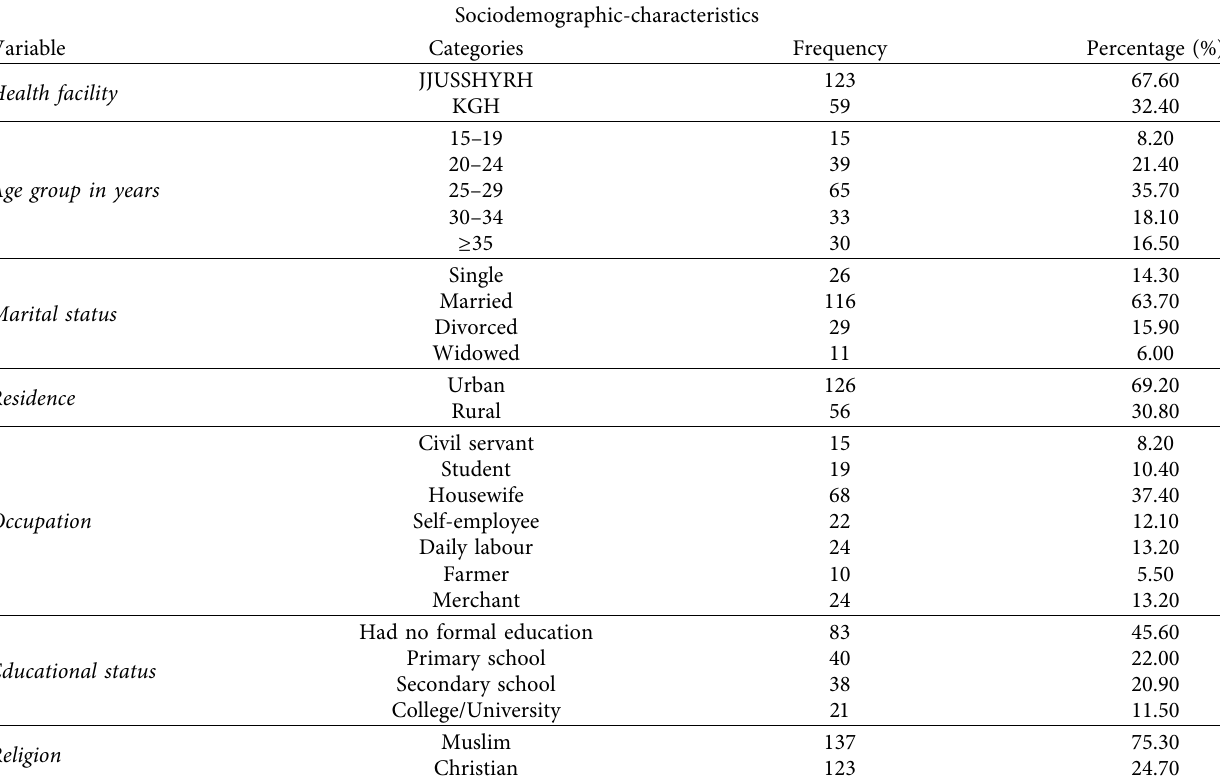
Table 1: Demographic characteristics of the participants at JJUSSHYRH and KGH in Jigjiga city, Southeast Ethiopia, March–May, 2021.